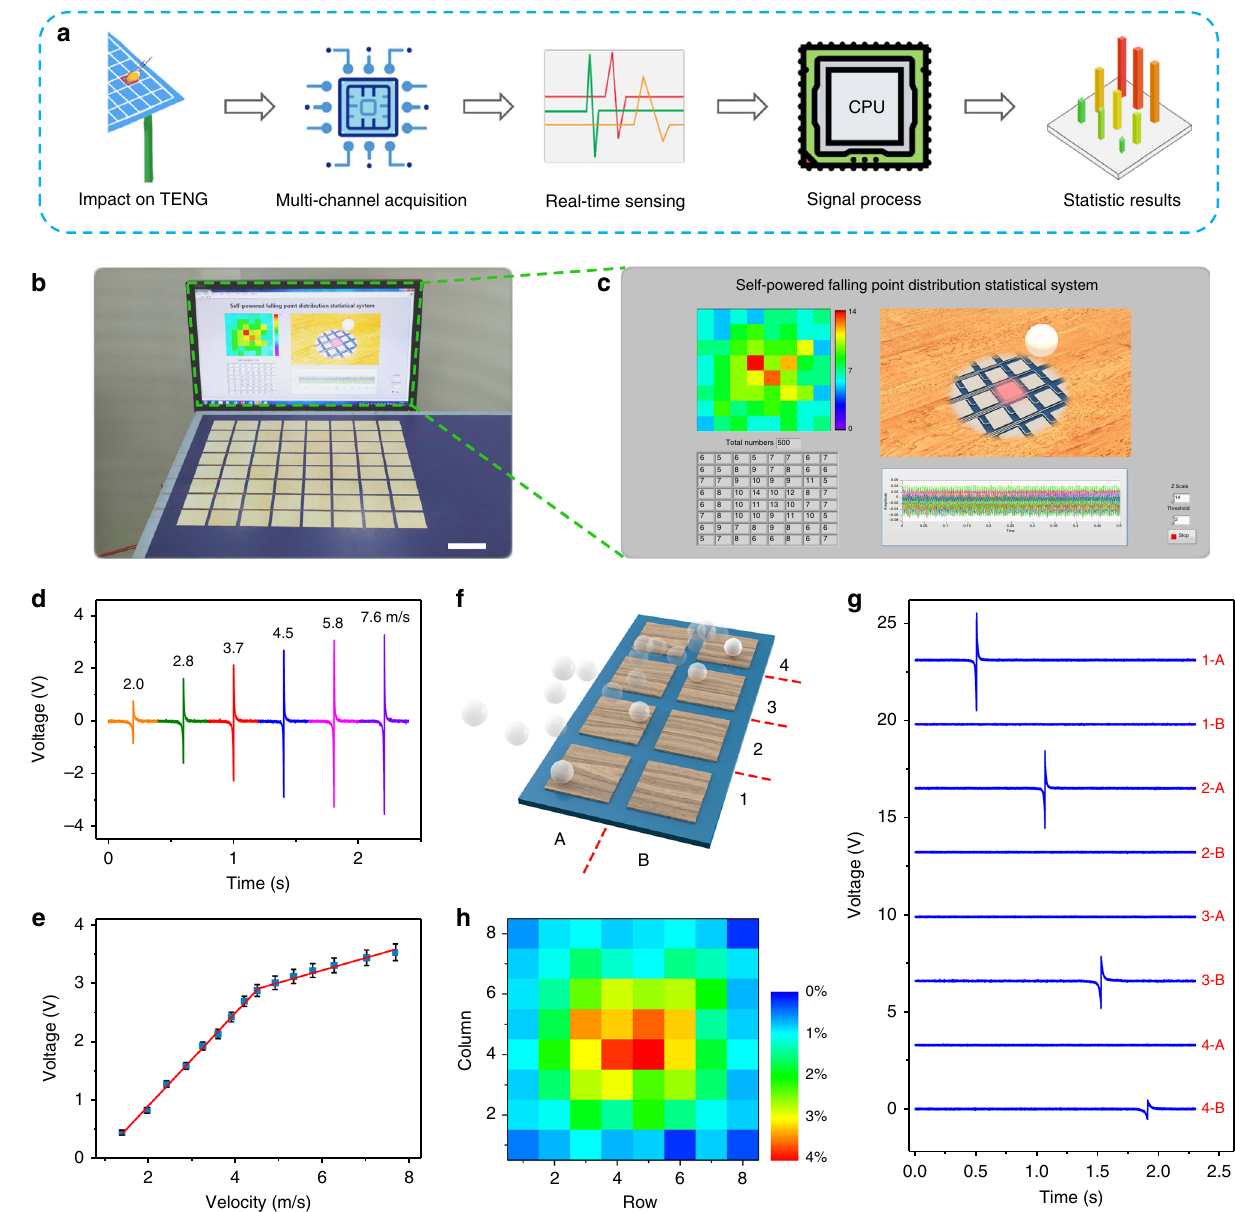
4-B4-A3-B3-A2-B2-A1-B l t V o Fig. 4 Application of the W-TENG in a self-powered falling point distribution statistical system. a Scheme diagram of the W-TENG based self-powered falling point distribution statistical system. b Demonstration of the self-powered falling point distribution statistical system. Scale bar, 6 cm. c Screenshot showing the real-time statistical result of the self-powered system. d The measured output voltage of the TENG under the impact of ping-pong balls with variable velocities. e The summarized relationship and linear fi tting between output voltages and velocities. Error bars indicate standard deviations for fi ve sets of data points. f Graphical illustration showing the moving path of the ping-pong ball above a 4 × 2 W-TES array. g Real-time output voltage signals when a ping-pong ball impacted the surface of a 4 × 2 W-TES array along a path: 1-A → 2-A → 3-B → 4-B. h 2D mapping fi gure showing the distribution the multi-channel data acquisition method, real-time voltage signals of each sensor unit could be detected at the same time. table for precisely detecting the falling point (Supplementary After signal processing, real-time statistic results can be displayed Fig. 16). The size of each W-TES unit is 4.5 × 4.5 cm 2 , and the gap in the program. Figure 4b shows the self-powered falling point between two adjacent units is 0.5 cm. Here, a synchronous data distribution statistical system. The enlarged view of this system is acquisition card (PXIe-4300, National Instruments) with inte- shown in Fig. 4c, including a mapping fi gure of distribution, grated signal conditioning was used for multi-channel output statistic results of each pixel, and real-time voltage signals of all voltage measurements. The equivalent circuit of this measuring the channels. For demonstration, a ping-pong ball was used to system is illustrated in Supplementary Fig. 17. As depicted in impact on different positions of the sensor array for fi ve times. Fig. 4a, while a ball impacts on the table surface, the W-TES at the Each impact can cause a corresponding update in the mapping fi gure and generate statistic results in each pixel, illustrating impact position will generate an obvious output signal. Through